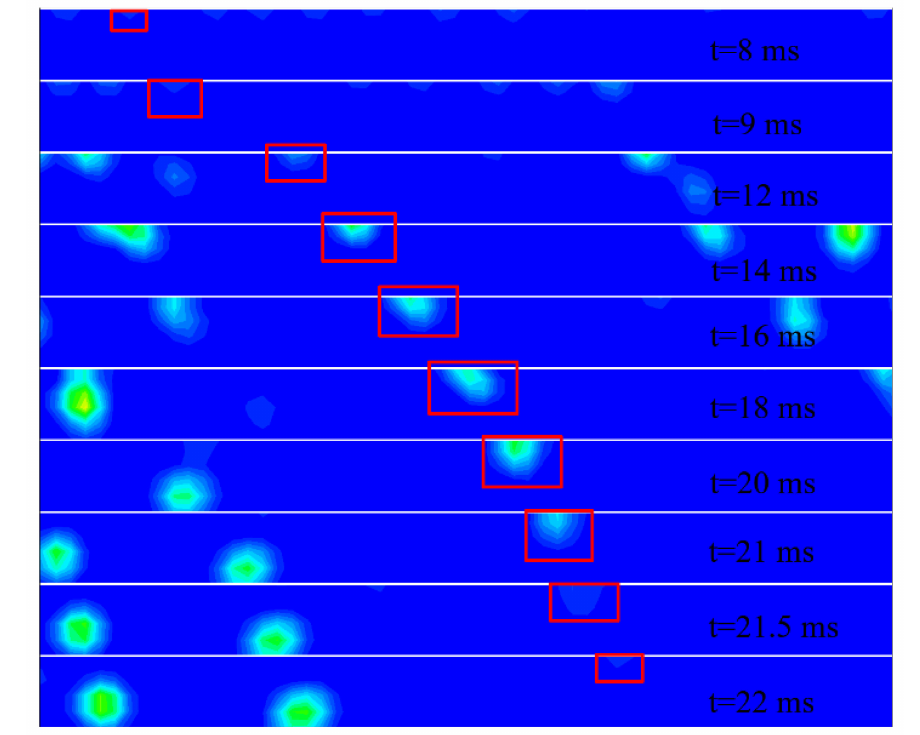
Figure 7. The developing process of a non-departed bubble with time.